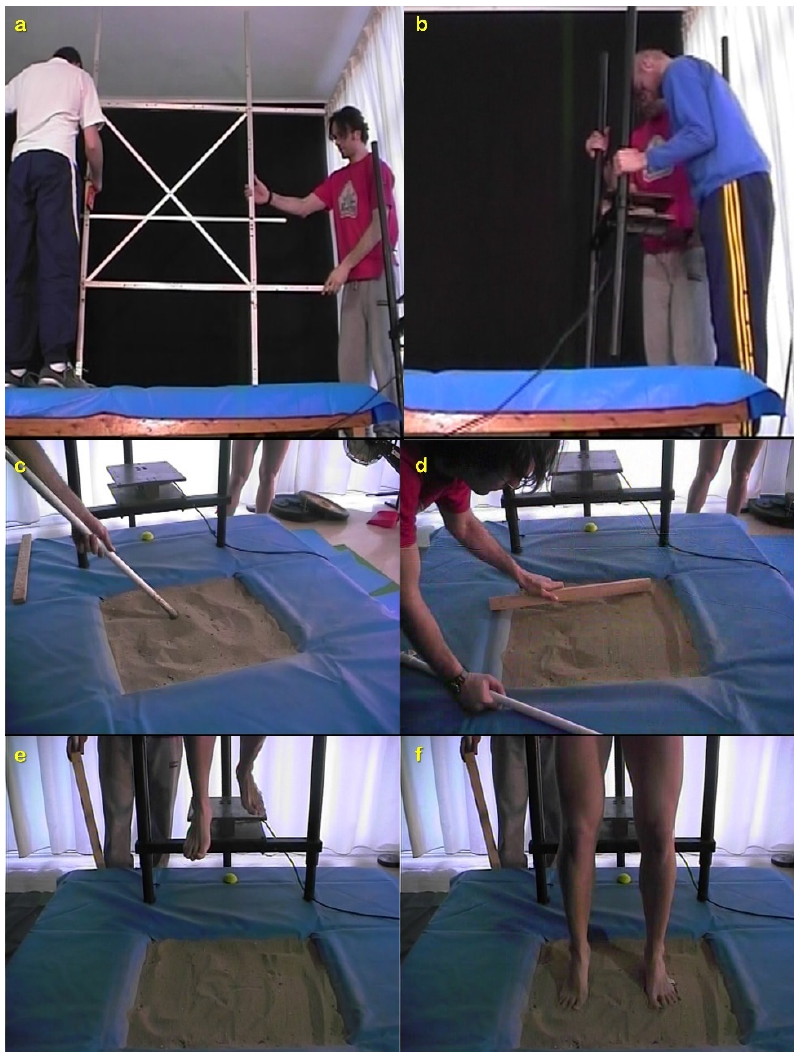
Figure 1. Experimental set-up and procedure for SAND: ( a ) calibration frame placement; ( b ) adjust- ment of the drop force-plate to the safety platform; ( c ) mixing the sand; ( d ) making the surface even; ( e ) take-off form the drop plate with a roll-off; ( f ) instant of touchdown in the sand pit where the examination for excessive plunging into the SAND was conducted.